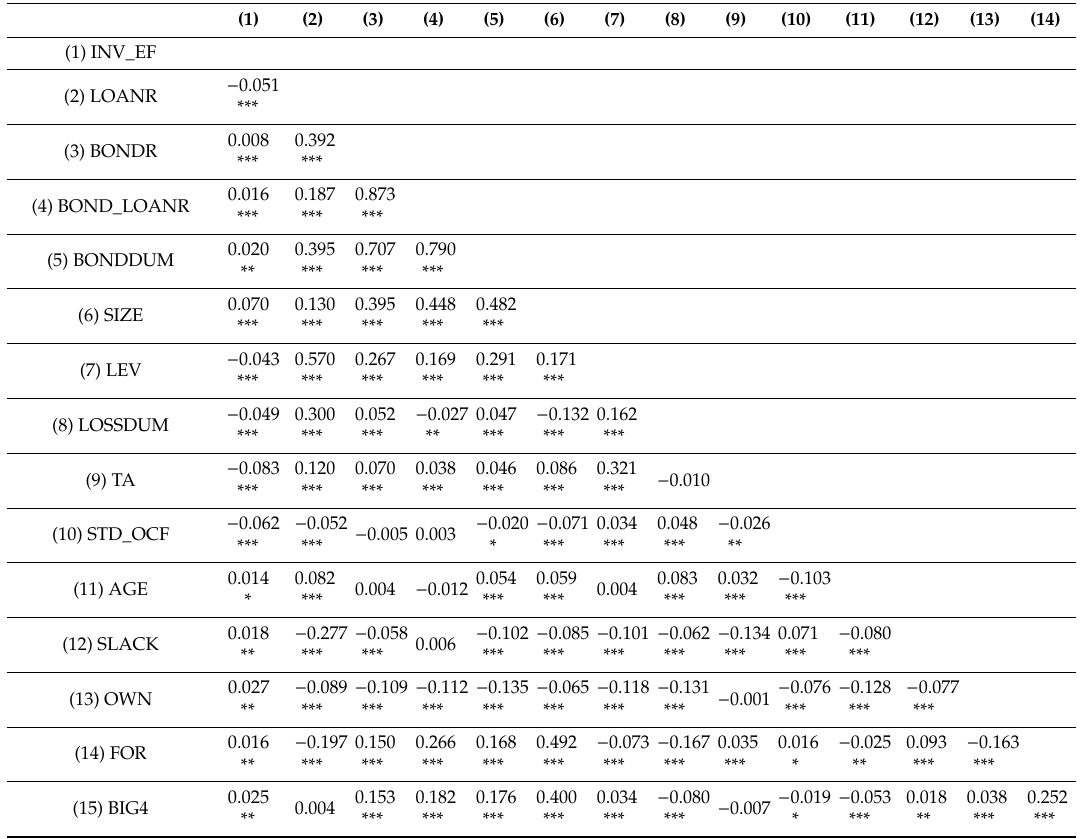
Table 4. Pearson correlations (n =